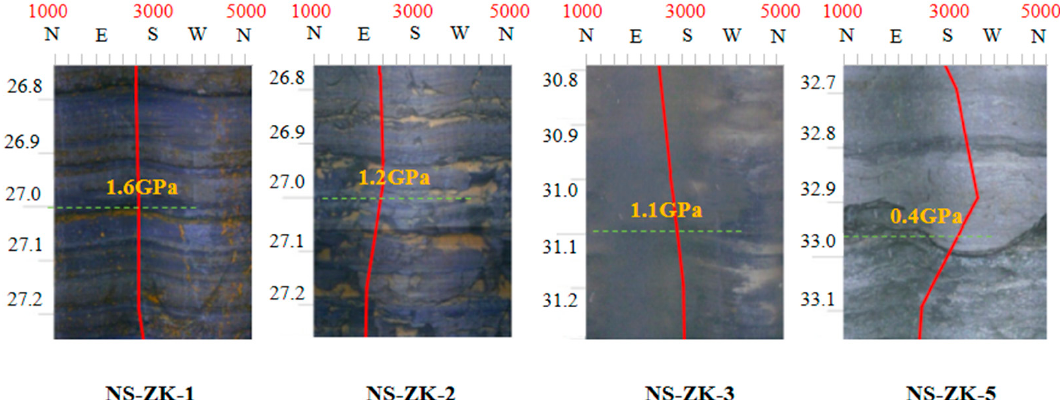
Figure 7. Borehole TV integration comparison.